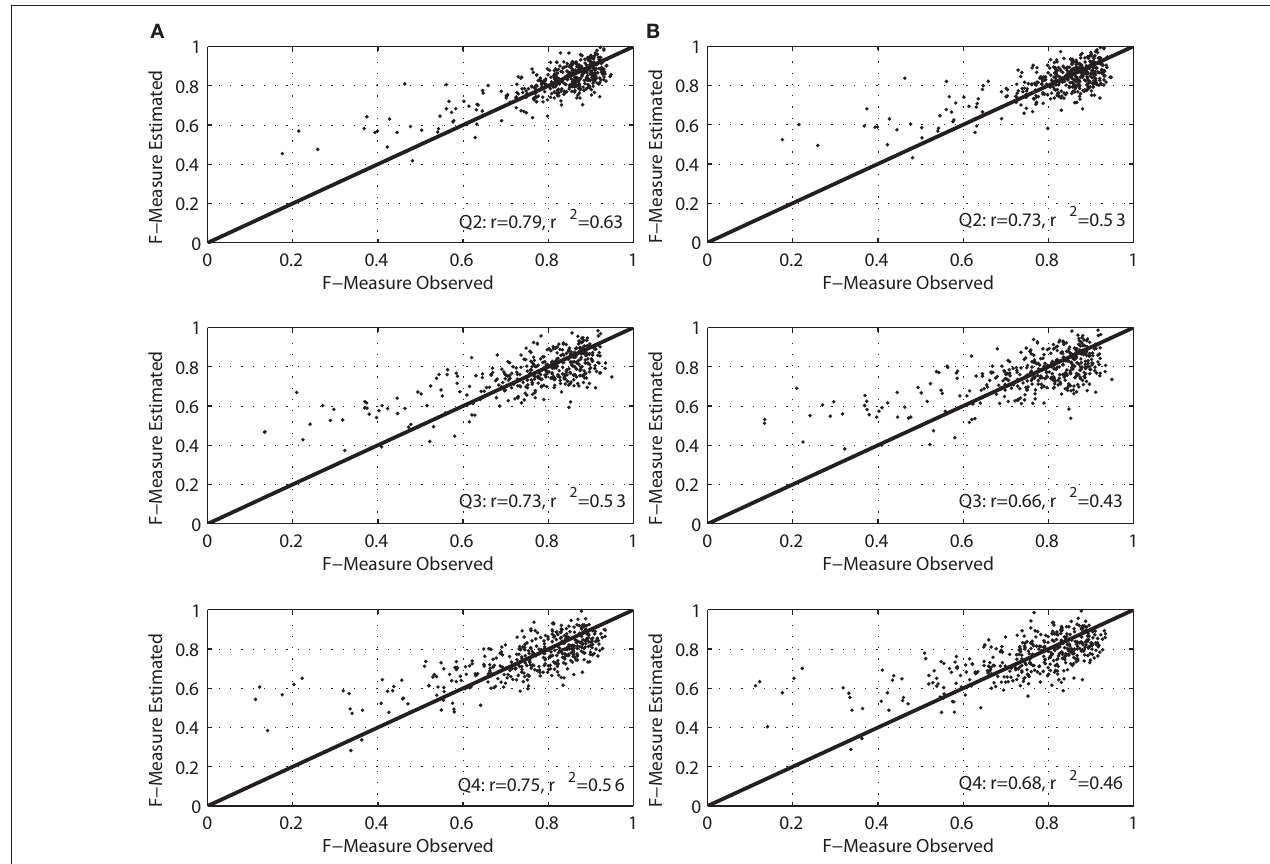
Figure 4 | Correlation plots between observed and estimated F -Measure for future performance by quartile. (A) The model development results, and (B) the